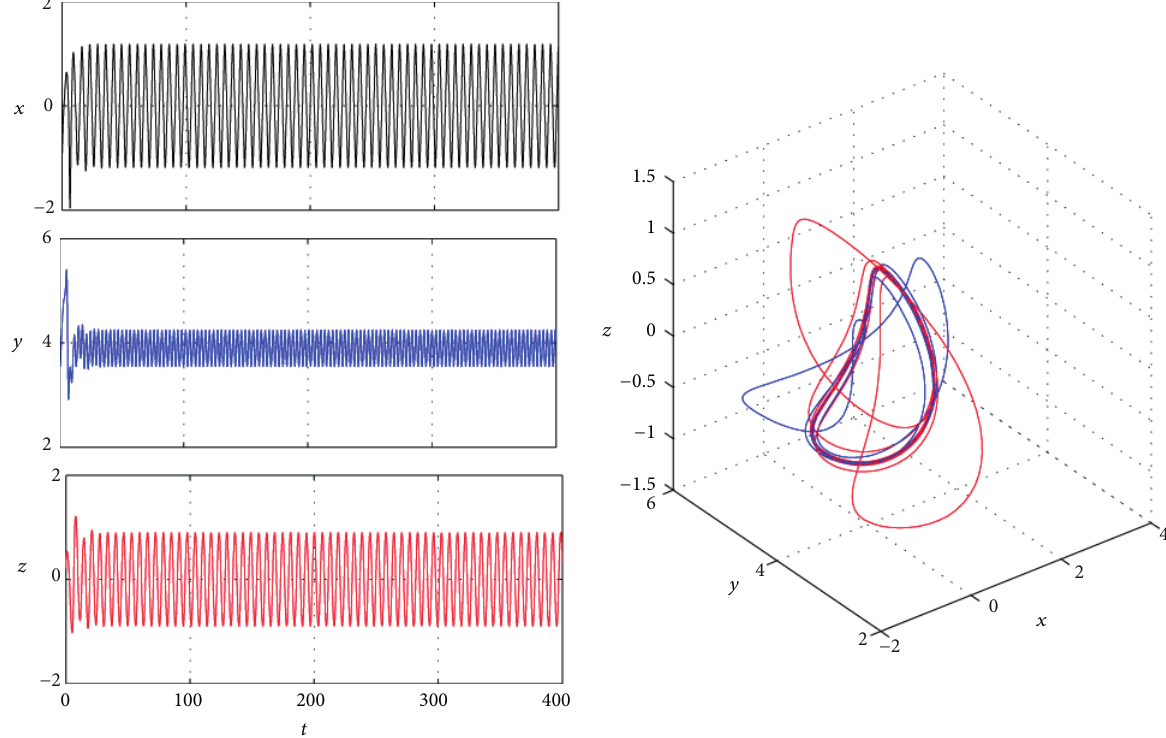
Figure 5: Trajectories 𝑥(𝑡) , 𝑦(𝑡) , and 𝑧(𝑡) and phase graphs of system (4) with 𝑎 = 4 , 𝑏 = 0.1 , 𝑐 = 1 , 𝑘 = 1 , 𝑑 = 1 , and 𝜏 = 2